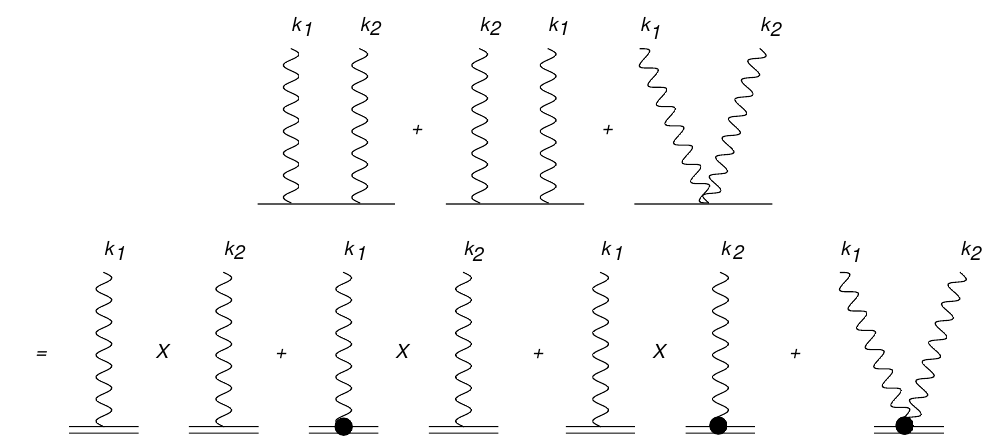
Figure 2 . Factorization of two graviton emissions of momenta k 1 and k 2 at order κ 2 . Diagrams on the l.h.s. are constructed with the full vertices of eq. (2.4) and eq. (2.5) and then expanded at next- to soft level. The diagrams on the r.h.s. instead contain the combined vertex-propagator Feynman rules of eq. (2.7), eq. (2.8) and eq. (2.9). Next-to-eikonal emissions are denoted with a